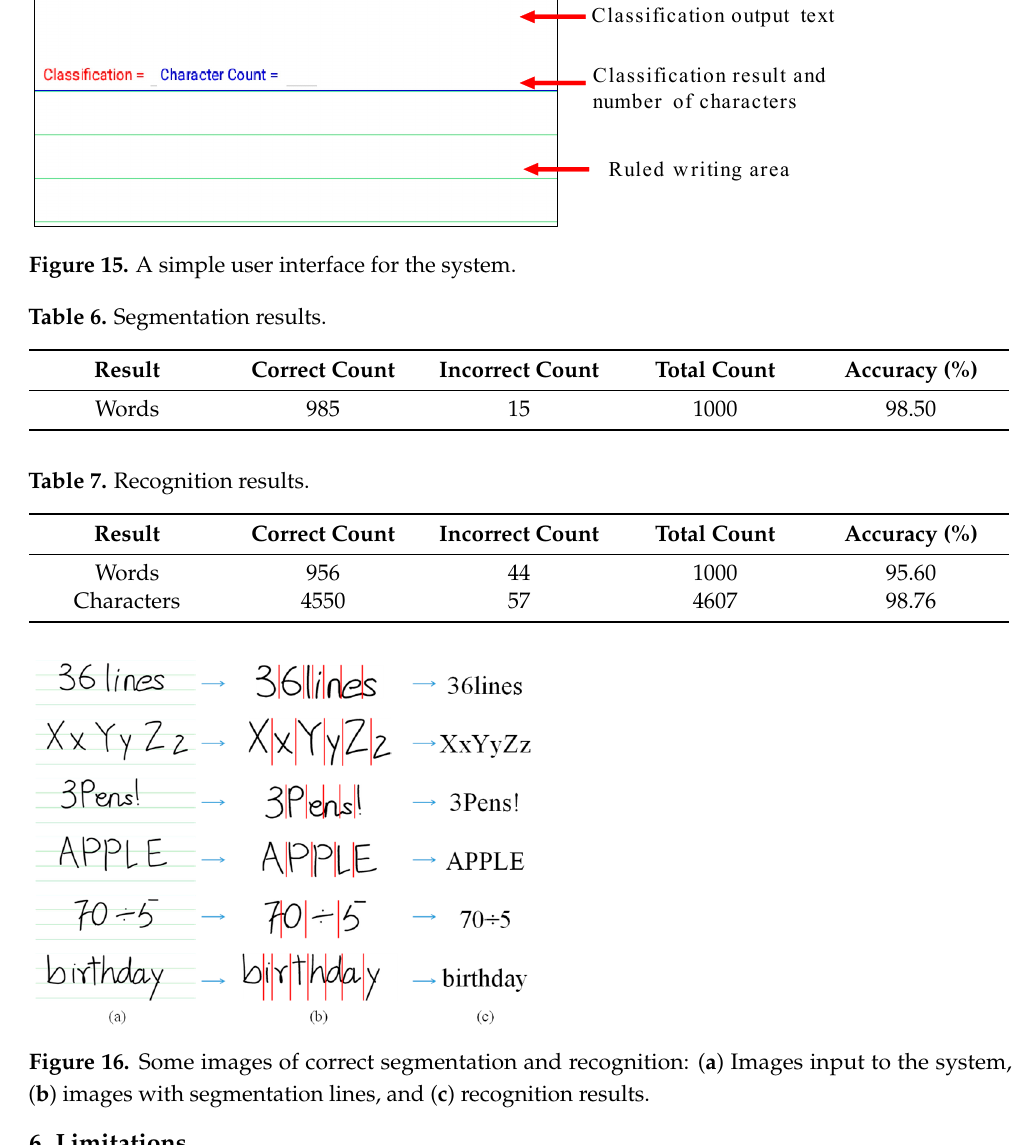
Figure 16. Some images of correct segmentation and recognition: ( a ) Images input to the system, ( b ) images with segmentation lines, and ( c ) recognition results.